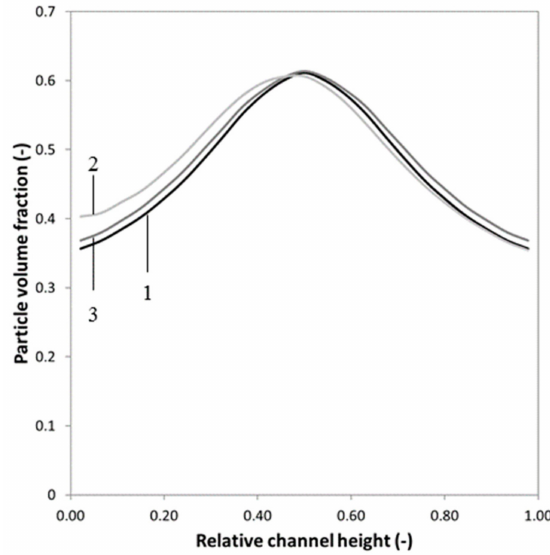
Figure 10. Particle volume fraction versus the relative channel height. The graph gives an indication of the shift in the SID profile of a suspension with a 50% bulk particle volume fraction: fully developed SID profile before the pore at 9.5 cm (black line, 1); disturbed SID profile just after the pore at ~10 cm (light grey line, 2) and the restored SID profile after the pore at 19.5 cm (dark grey line,